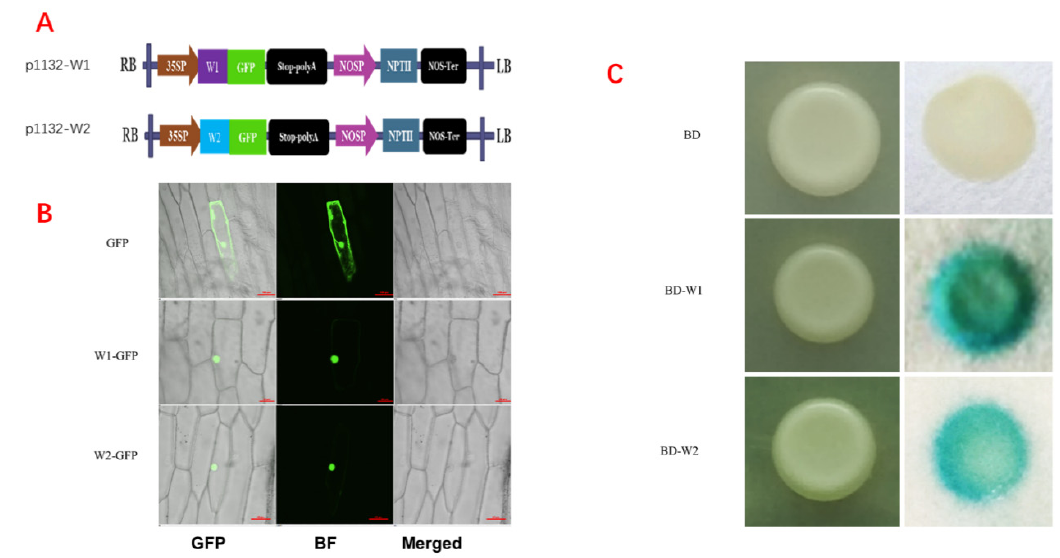
Figure 3. Expression characteristics of TaWRI1Ls . ( A ) The transient expression vectors pYBA1132-W1 ( TaWRI1L1-5 B) and pYBA1132-W2 ( TaWRI1L2-5A ). ( B ) The subcellular localization of TaWRI1Ls . Bars = 50 µm. ( C ) Yeast transcriptional activity analysis of pBD-W1 ( TaWRI1L1-5B ) and pBD-W2 ( TaWRI1L2-5A ).